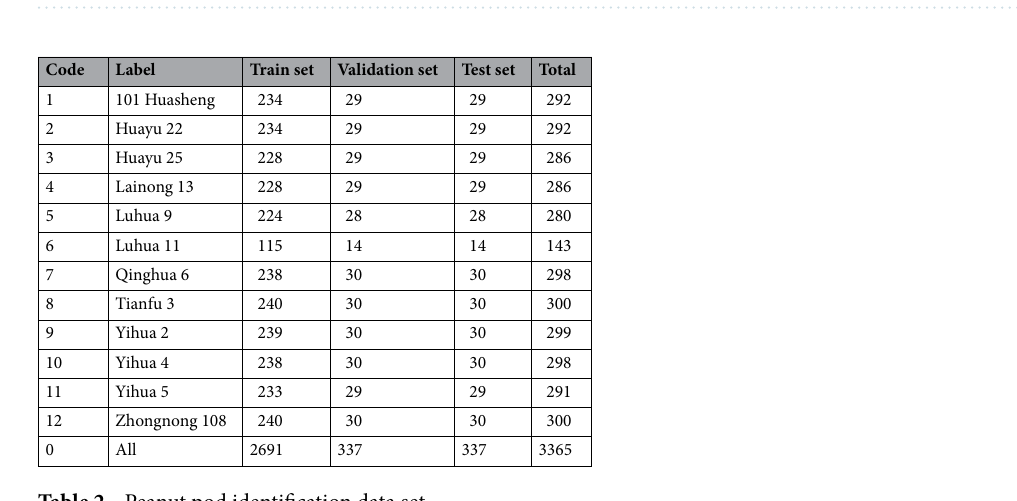
Figure 3. Images of 12 peanut varieties.